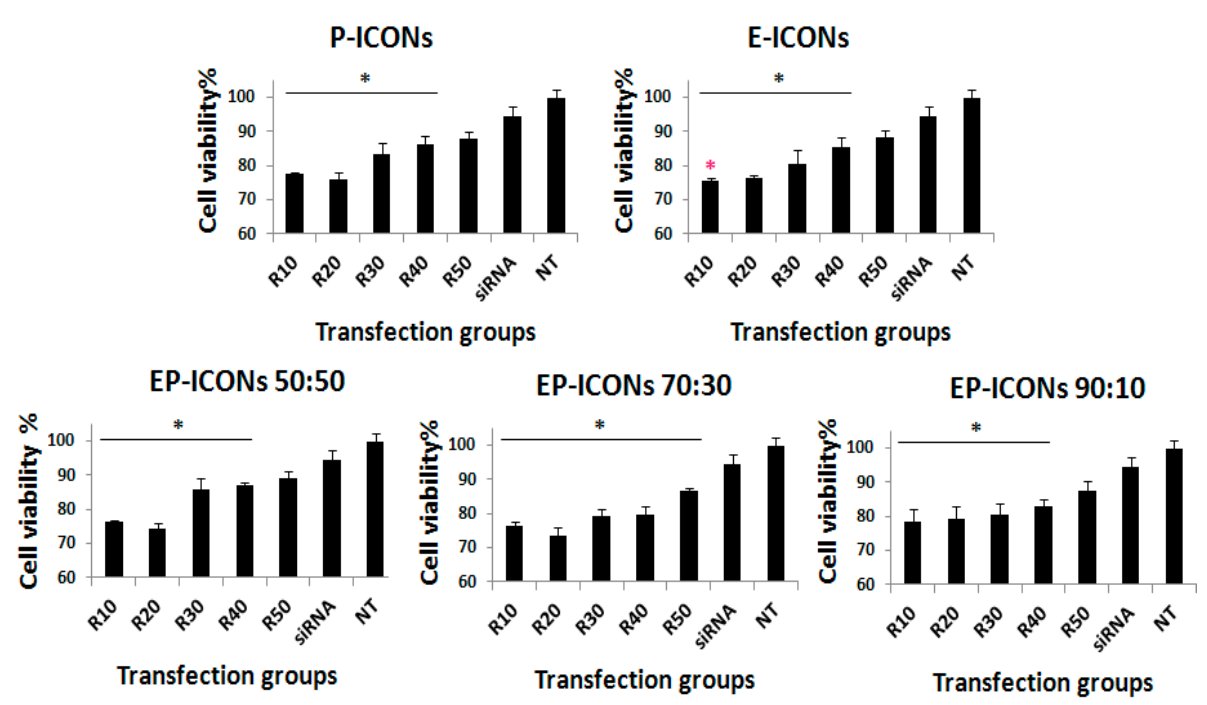
Figure 7. Proliferation of MCF-7 cells after 72 h incubation with E-ICONs, P-ICONs, or EP-ICONs containing survivin targeted siRNA. * represents p < 0.05 with respect to siRNA naked treated cells. A red asterisk on E-ICONs R10 represents significant reduction when compared with P-ICONs at the same weight ratio. (red * p < 0.05)